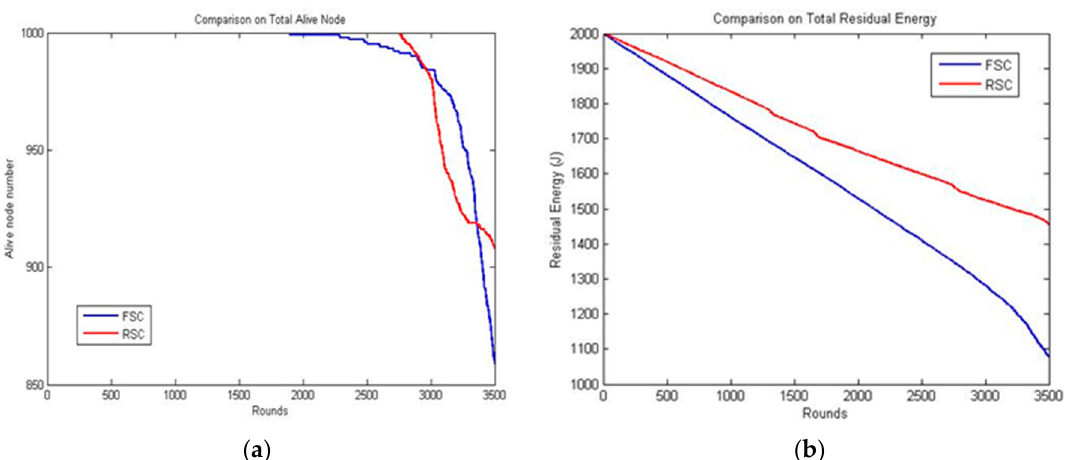
Figure 5. Comparison of RSC and FSC: ( a ) the number of live nodes and ( b ) the total residual energy.